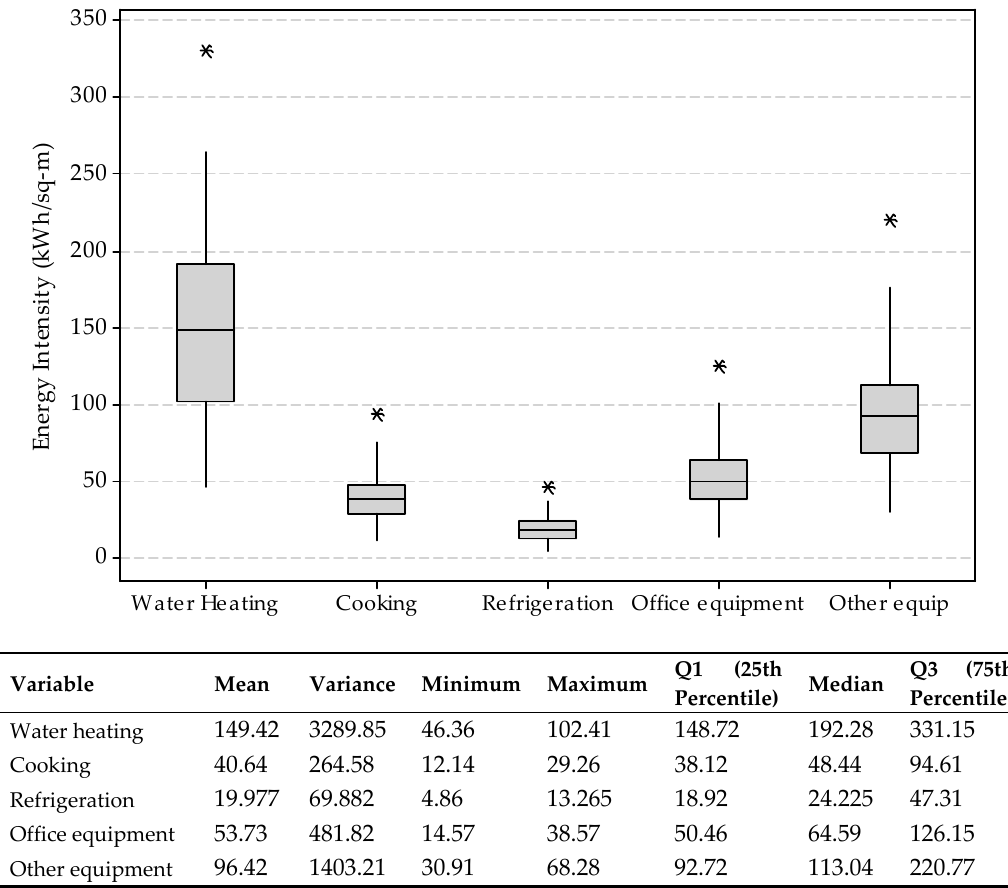
Figure 8. Boxplot of annual process energy intensity (kWh / m 2 ) in healthcare facilities (*